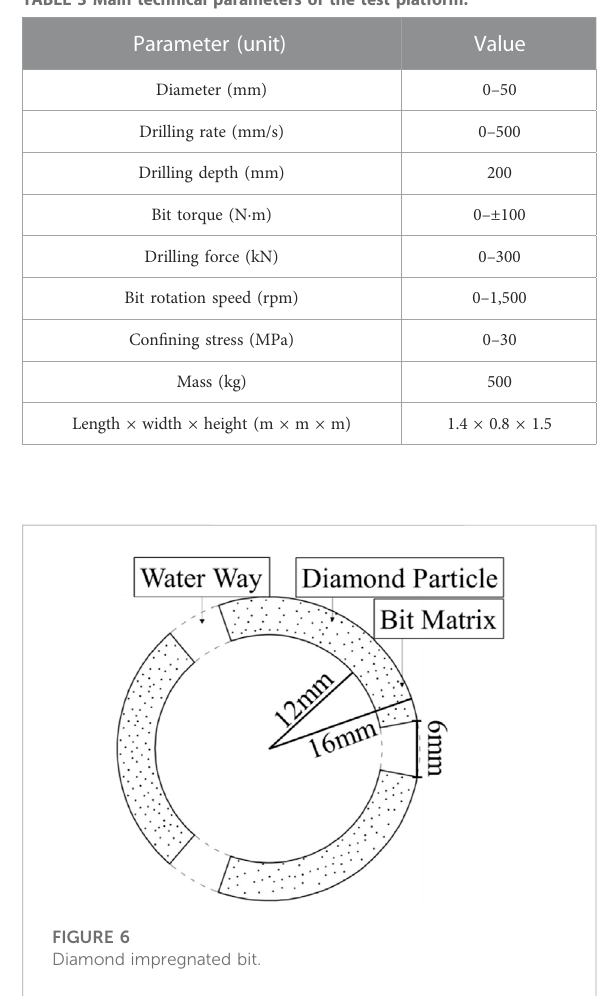
TABLE 3 Main technical parameters of the test platform.